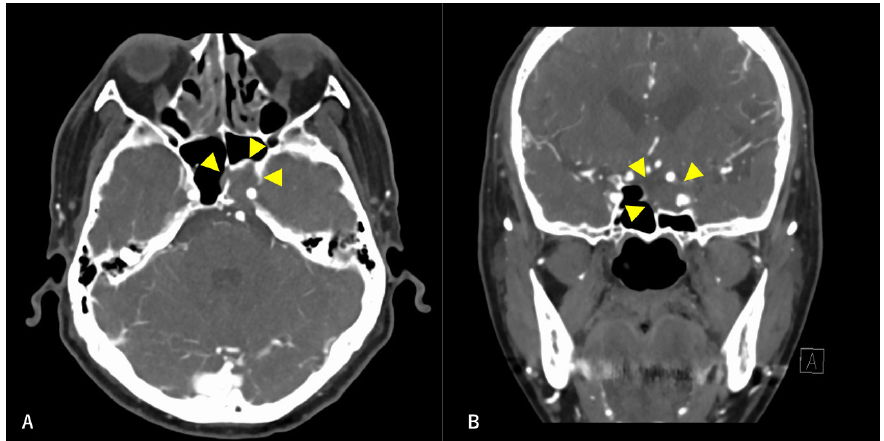
Figure 1. Preoperative contrast-enhanced computed tomography (CT) findings. Axial section ( A ) and coronal ( B ) images are shown. An isodense area with surrounding bone destruction is observed in the left sphenoid sinus, and no surrounding bone is observed around the internal carotid artery (ICA). Arrowheads indicate tumors.